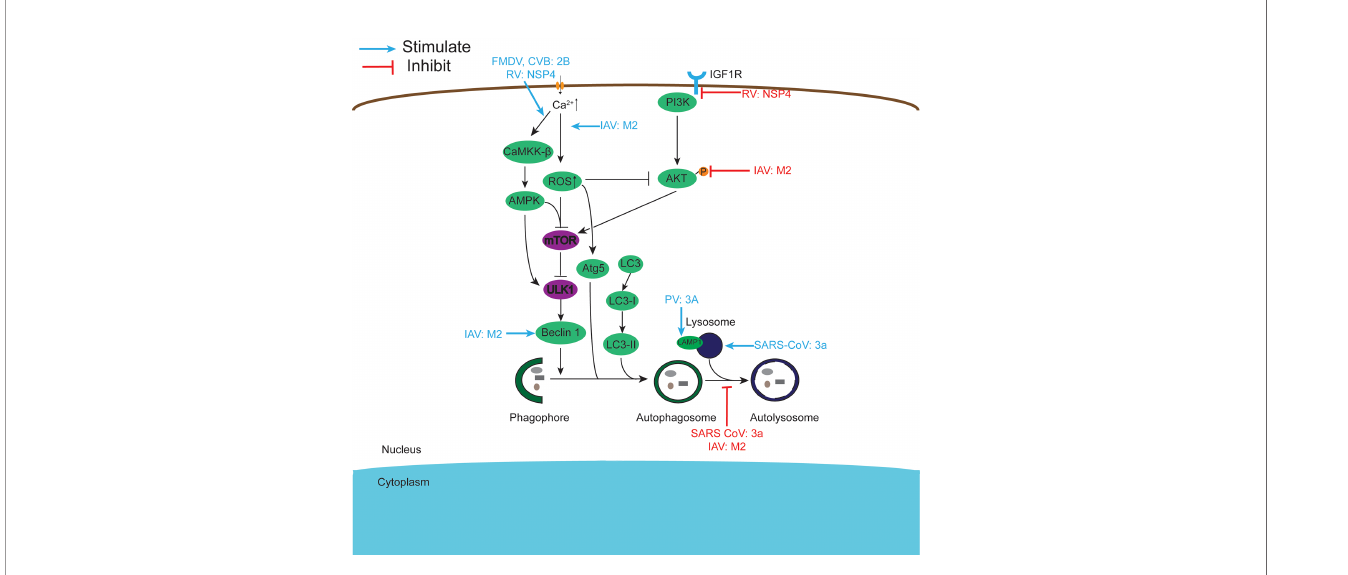
FIGURE 4 | Viroporins regulate autophagy. Autophagy can be regulated by the PI3K-AKT-mTOR signaling pathway and the AMPK-TSC1/2-mTOR signaling pathway. Viroporins can regulate autophagy by regulating upstream signaling cascades, interfering with the formation of autophagosomes to activate, inhibit autophagy and fuse with lysosomes, and interact with key molecules of autophagy.